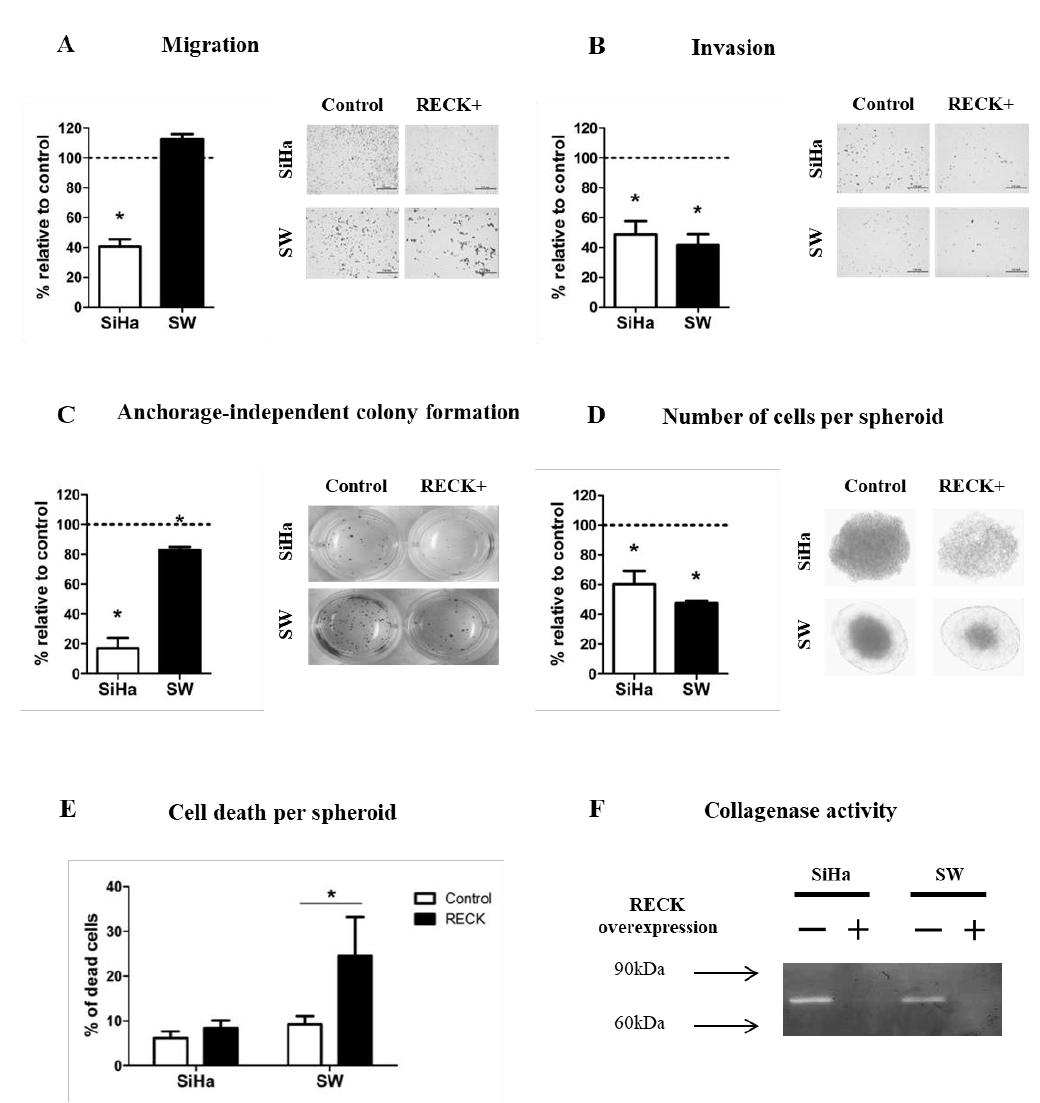
Figure 2. RECK over expression reduces SiHa and SW756 cell lines invasion potential and 3D growth. ( A , B ) Chamber migration and invasion assays. Cells present in 10 independent fields per chamber were counted. ( C ) Anchorage inde- pendent growth assay. After 30 days in culture, three-dimensional colonies were stained using MTT and all visible colonies were counted. ( D , E ) Spheroid formation assay. After 7 days in culture, spheroids were dissociated, stained with Trypan blue and counted. ( F ) Gelatinase activity assay. Zymography was carried out by subjecting 30 ug of protein to SDS-PAGE supplemented with 5% gelatin. After electrophoresis, the gel was incubated in an activation solution at 37 °C for 48 h, the gel was then stained with 0.5% crystal violet and images were developed with use of MultiDoc-It TM 120 Imaging System (Analytic Jena, Upland, CA, USA). All experiments were carried out in triplicates. * p < 0.05 by Mann–Whitney (2A–E) test.